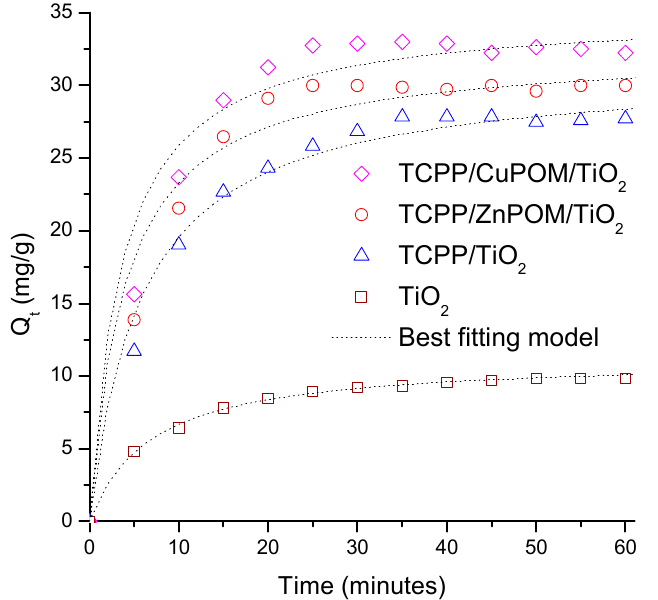
Figure 6. Experimental kinetic data for MB adsorption onto thin films. Inside the figure, the best fitting model is shown (pseudo-second model). Table 3. Results at equilibrium